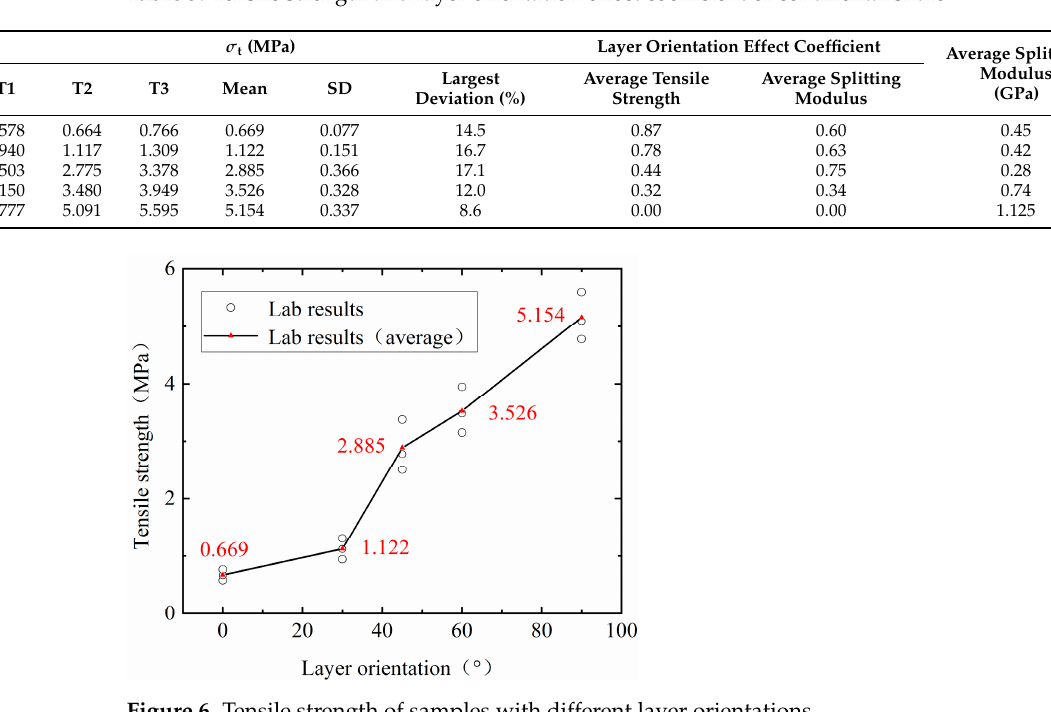
Table 3. Tensile strength and layer orientation effect coefficient of continental shale.